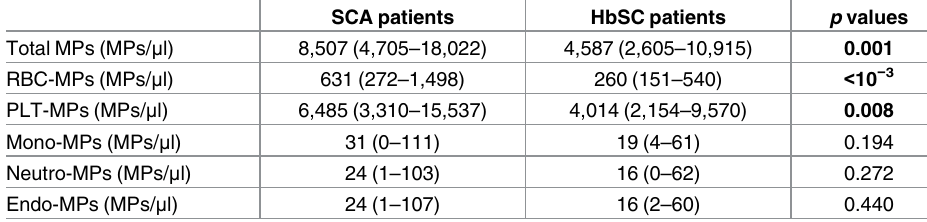
Table 2. Cellular origins and blood MP concentrations of SCA and HbSC